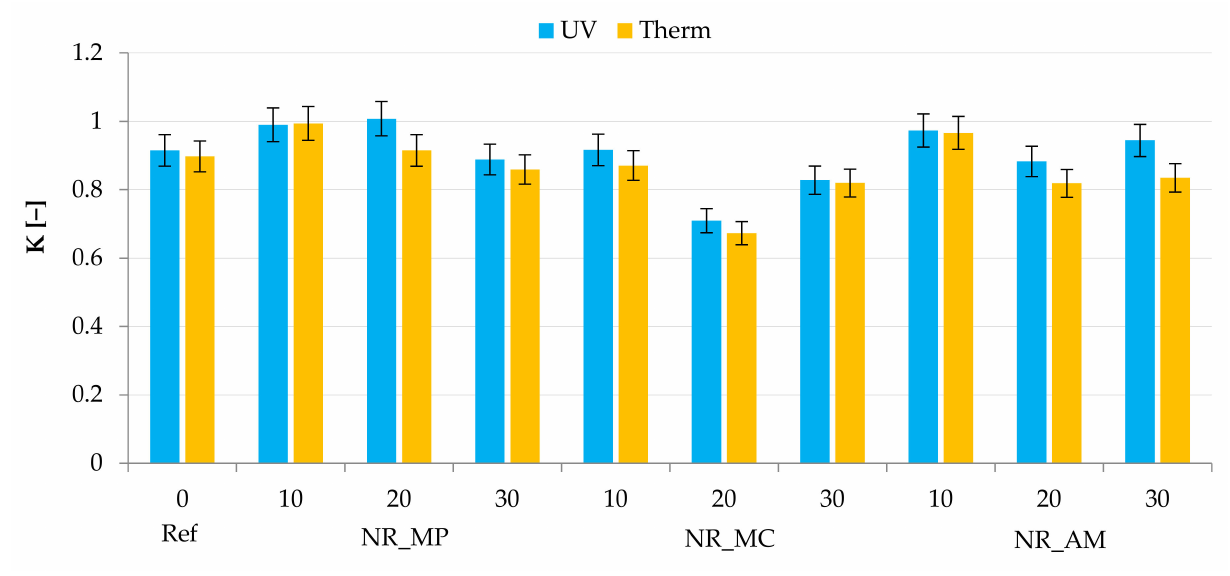
Figure 13. Aging factor